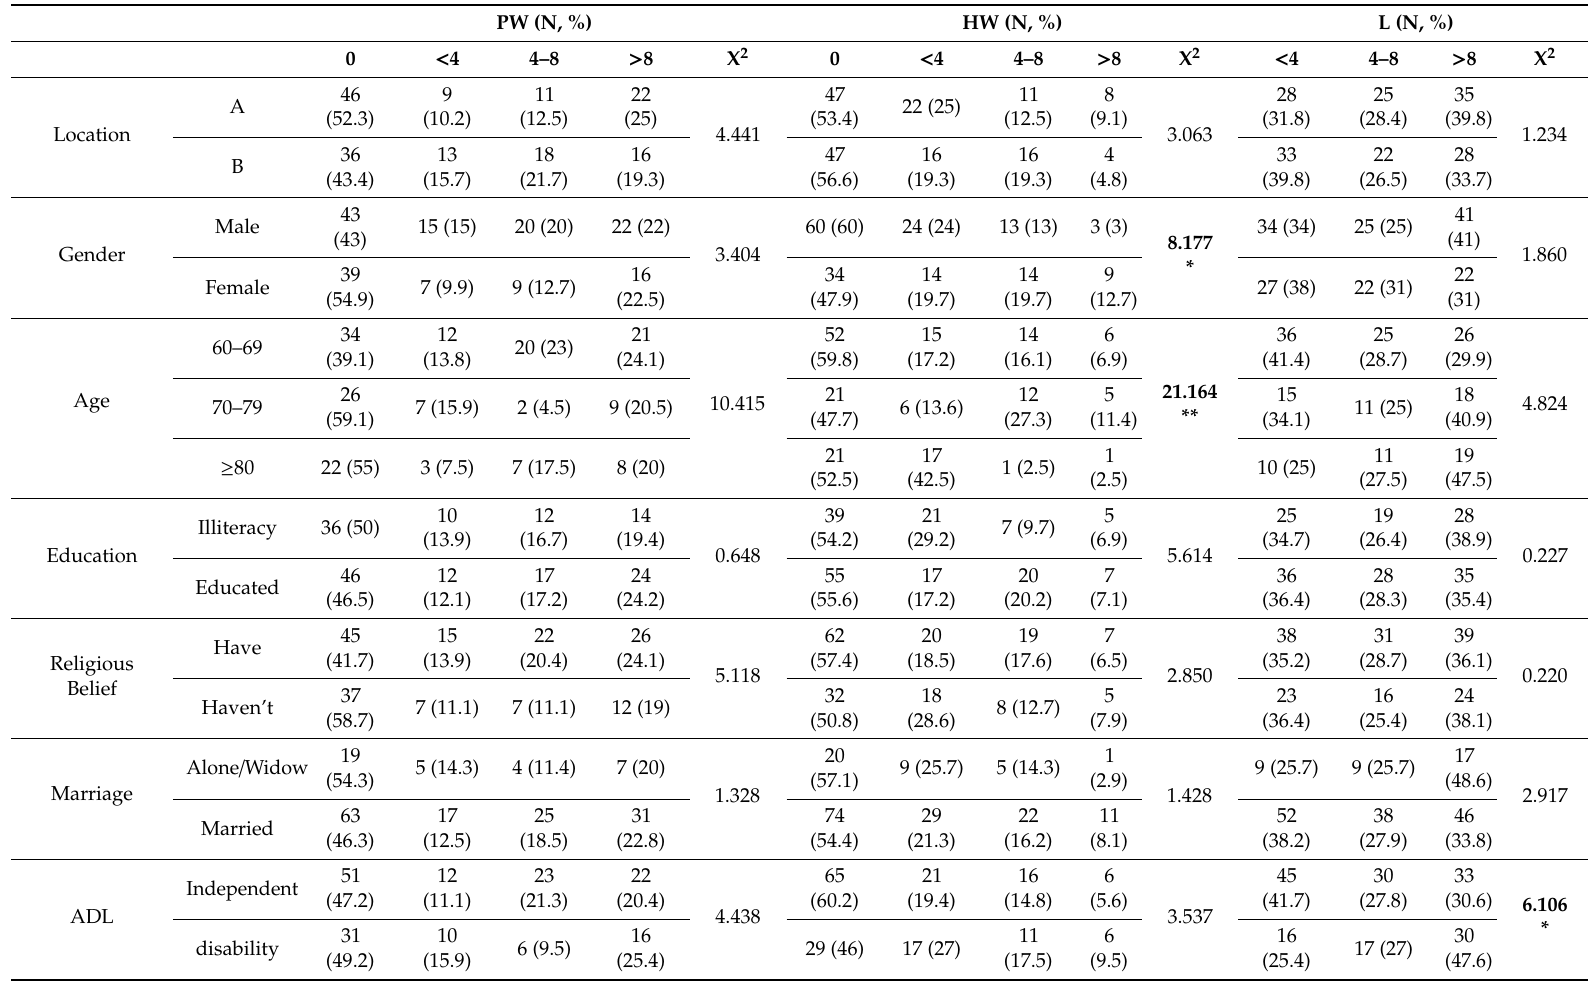
Table 2. Relation between activities to personal attributes, competence and subjective